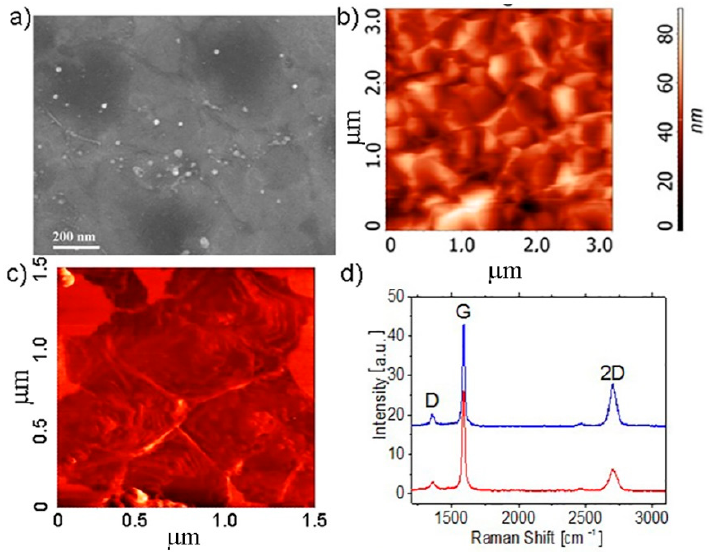
Figure 2. The scanning electron microscopy (SEM) ( a ) and AFM (b,c) images of CVD-grown multilayer graphene (MG) films transferred to the SiO2/Si (c) substrates and PET ( b ) with the use of a laminator. The AFM images were measured in the regime of the height ( b ) and the frictional forces ( c ). The MG thickness in pyramid tops was about 8-10 nm. ( d ) The Raman spectra for MG on SiO2/Si substrate measured in the two different points.